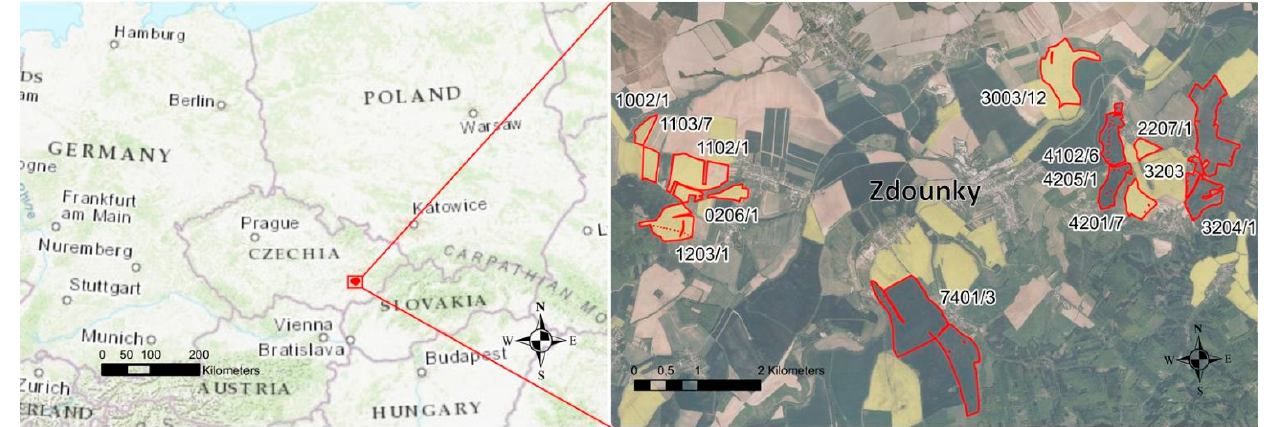
Figure 1. Localization of experimental fields. Individual experimental plots are marked with numerical codes. The field experiment was performed from 2017 to 2020. Every year, min. 200 ha of arable land were selected (Table 1) to be sown with winter wheat ( Triticum aestivum L.), which was a subject of the ISARIA system and satellite Sentinel-2. Winter wheat was cul- tivated using the conventional methods every year. Only the winter wheat intended for food purposes was monitored (2017: Viriato ; 2018: Dagmar ; 2019: Viriato ; 2020: Viriato ). The Viriato variety is legally protected and bred by Société RAGT 2n (FR) and the Dagmar variety by Limagrain Central Europe Cereals, s.r.o. (CZ, FR). These varieties can be de-